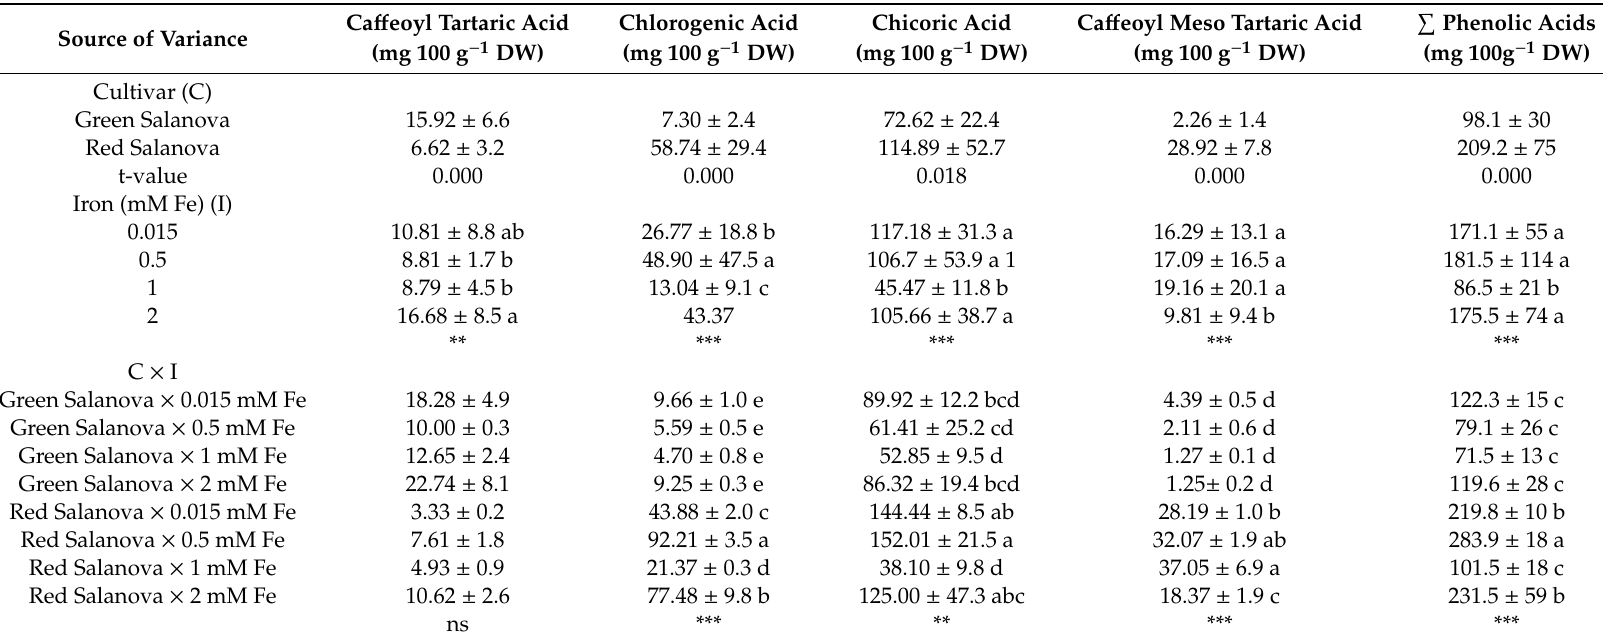
Table 3. Analysis of variance and mean comparisons for target phenolic acids, total phenolic acids and anthocyanins in green and red Salanova butterhead lettuce grown under increasing Fe concentration in the nutrient